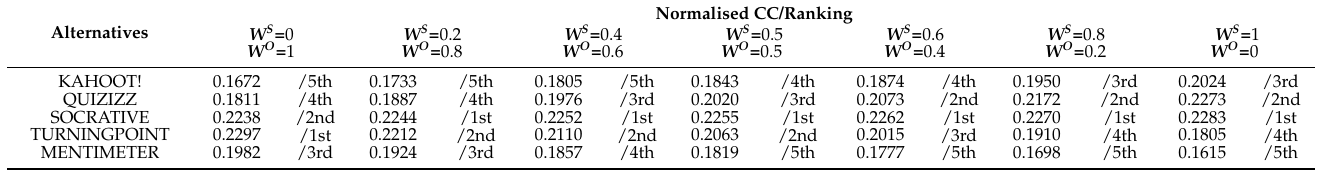
Table 19. Sensitivity analysis with objective weights from De Luca and Termini entropy.